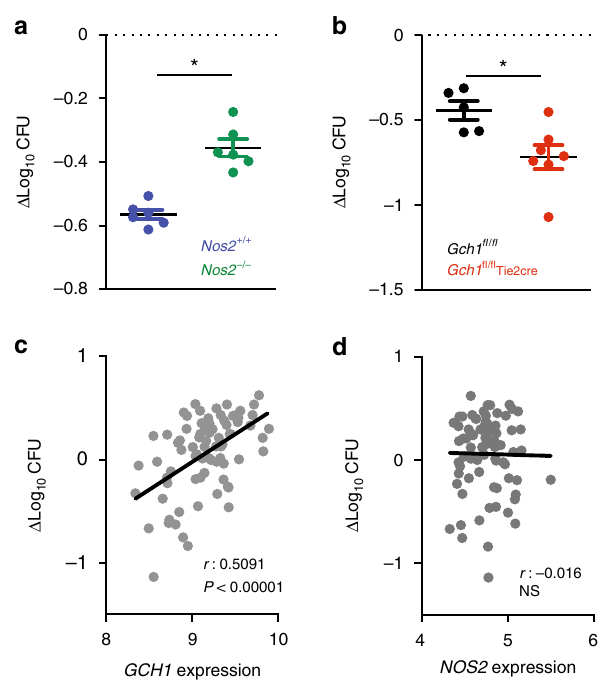
Fig. 10 Gch1 expression inversely correlates with control of BCG infection in vitro. a , b A mycobacterial growth inhibition assay was performed using Nos2 − / − ( a ) and Gch1 − / ( b ) BMDM cells. Macrophages were infected with 50:1 MOI BCG in the presence of 10 ng/ml IFN γ and the live BCG remaining after 96 h was enumerated by the BACTEC Mycobacterial Growth Indicator Tube (MGIT) system (MGIA), n = 6 per genotype Nos2 + / + and Nos2 − / − , n = 5 Gch1 fl / fl and n = 5 Gch1 fl / fl Tie2cre n = 7 p < 0.05 (t-test), individual points with SEM shown. Δ log 10 CFU = log 10 CFU sample − log 10 CFU positive control. Error bars are ±SEM. c , d Pearson correlation between GCH1 expression and in vitro BCG growth in PBMCs of 78 BCG vaccinated South African infants. Points represent the mean of duplicate cultures. Δ